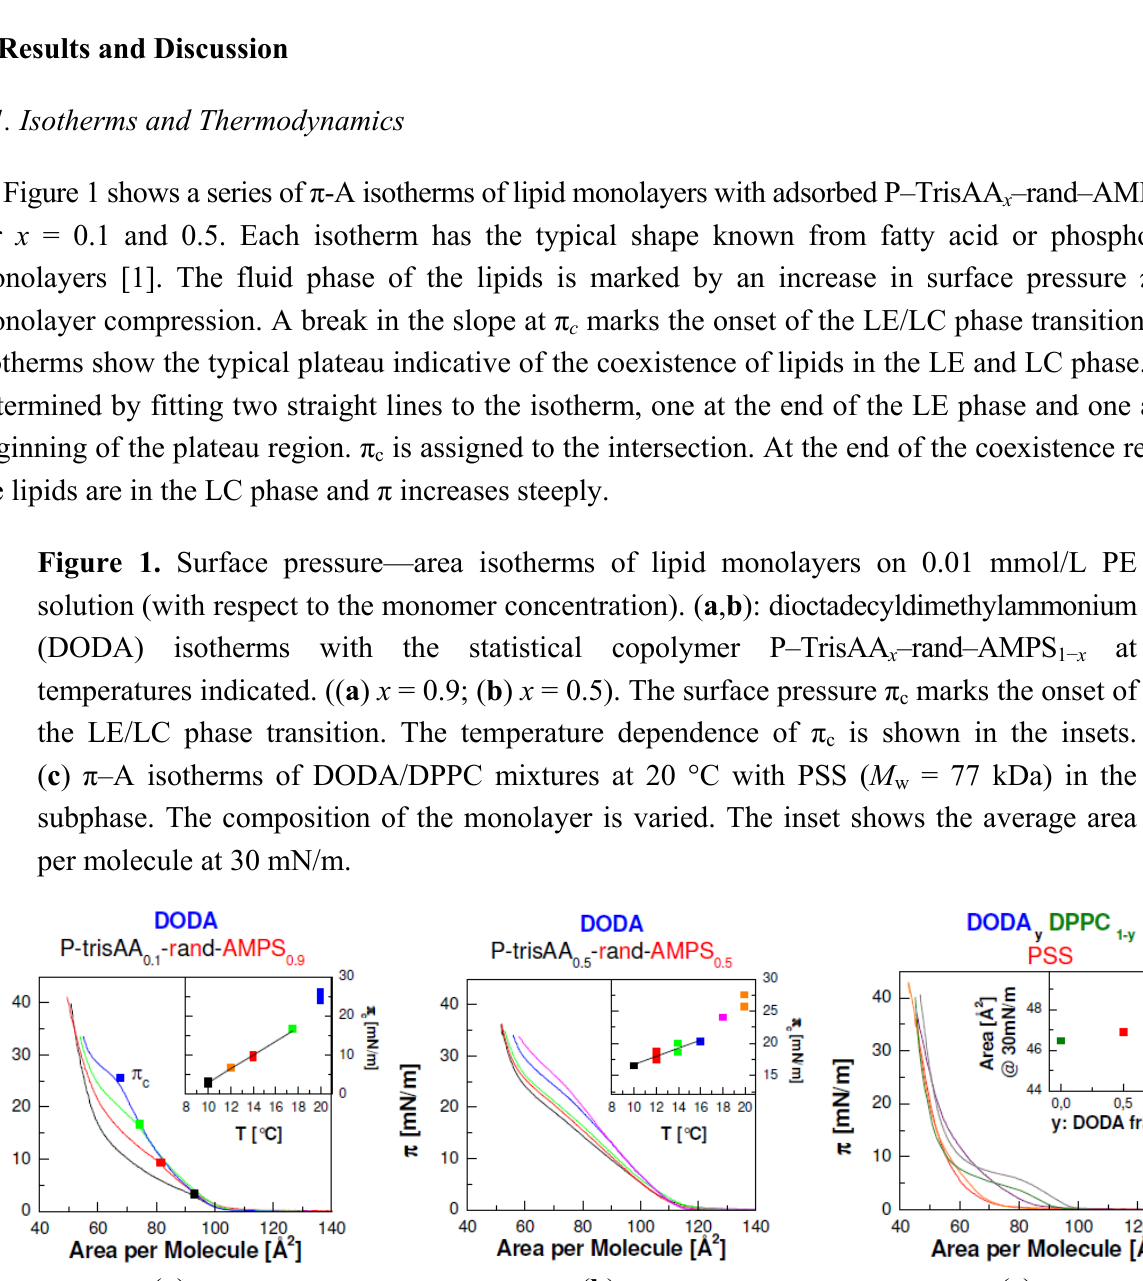
–rand–AMPS at x 1 − x marks the onset of c is shown in the insets. c = 77 kDa) in w